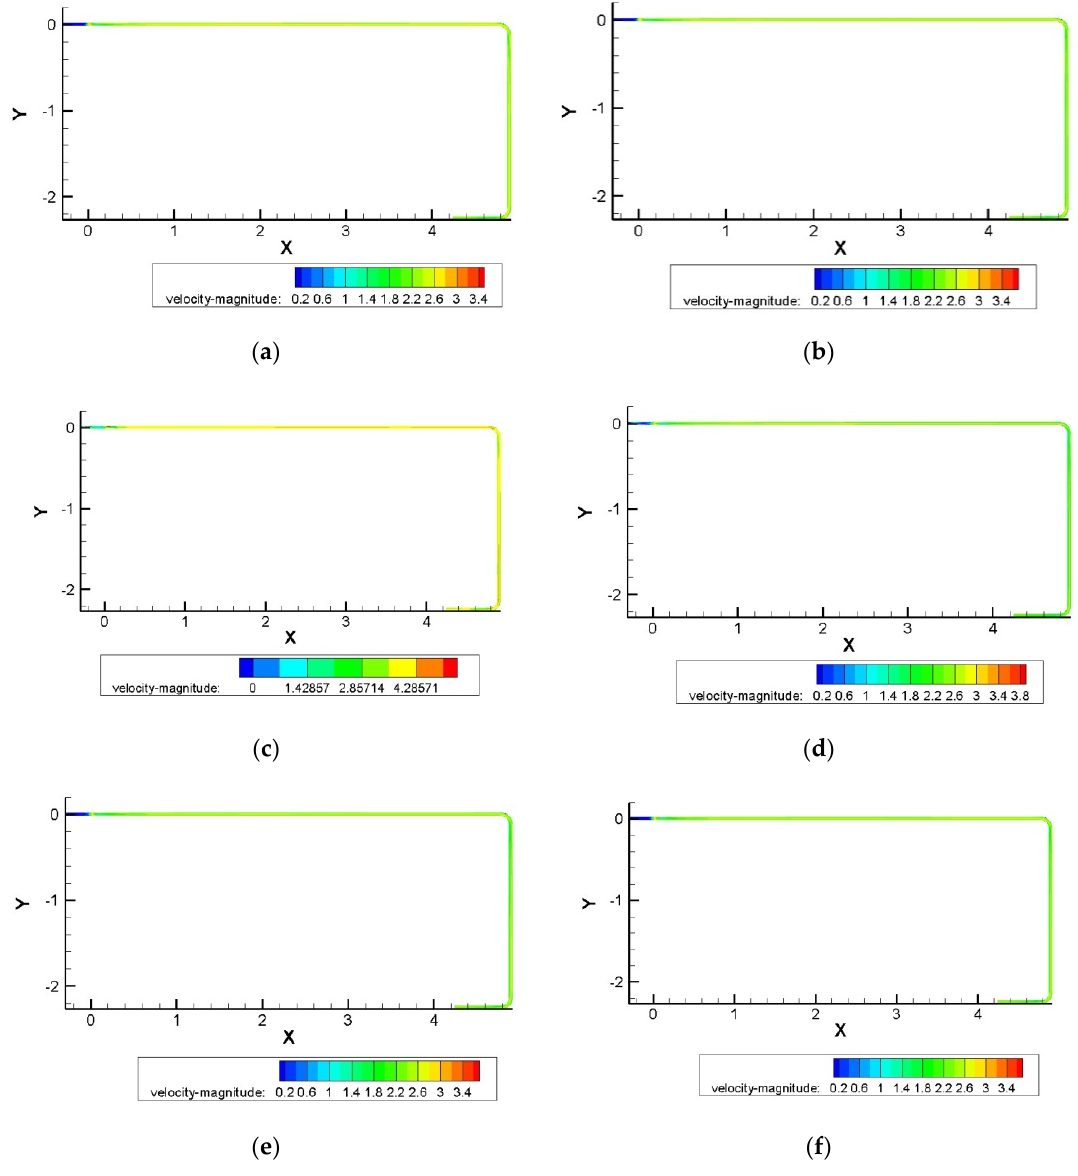
Figure 6. The water-phase velocity distribution of horizontal axis intersecting surface within a period: ( a ) t = 0; ( b ) t = 2 s; ( c ) t = 4 s; ( d ) t = 6 s; ( e ) t = 8 s; ( f ) t = 10 s.